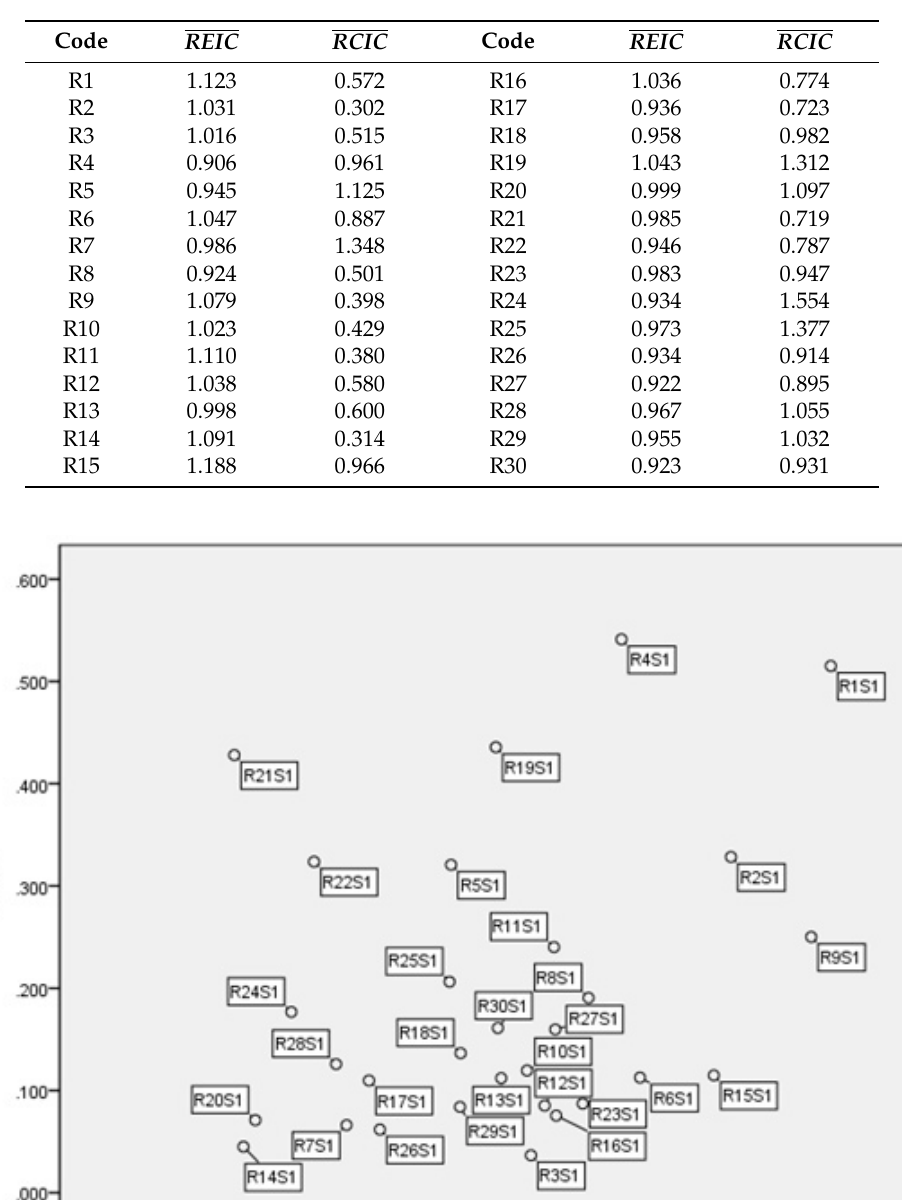
Table A4. REIC and RCIC of China’s 30 regions in 2010.